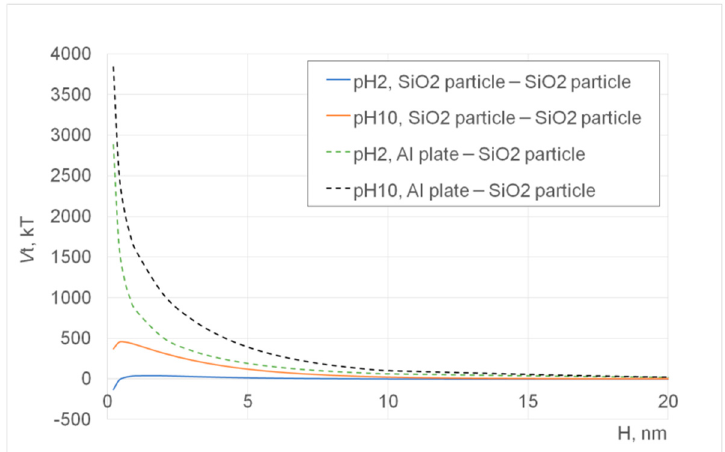
Figure 6. DLVO total potential energies between silica–silica particles with the radius of 280 nm as well as between the Al stub plate and silica particles at pH 2 or 10 and 1 × 10 − 2 M KNO 3 aqueous solution at 25 °C, as a function of interparticle separation distance. The unit of the potential, V t is the thermal energy, k B T [J].